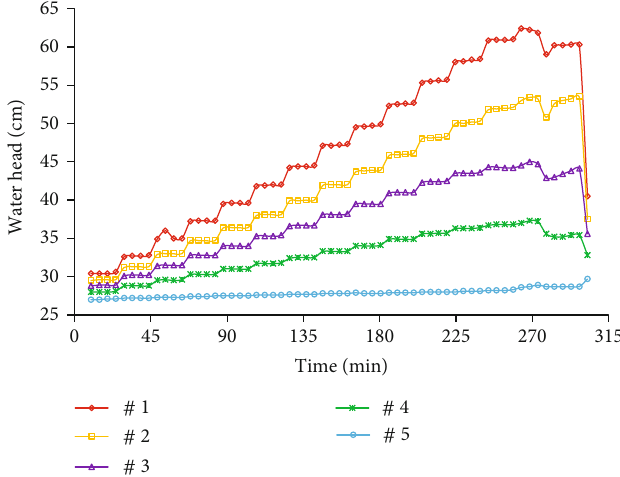
Figure 5: Process curve of water head of di ff erent piezometers in soil numbered C.